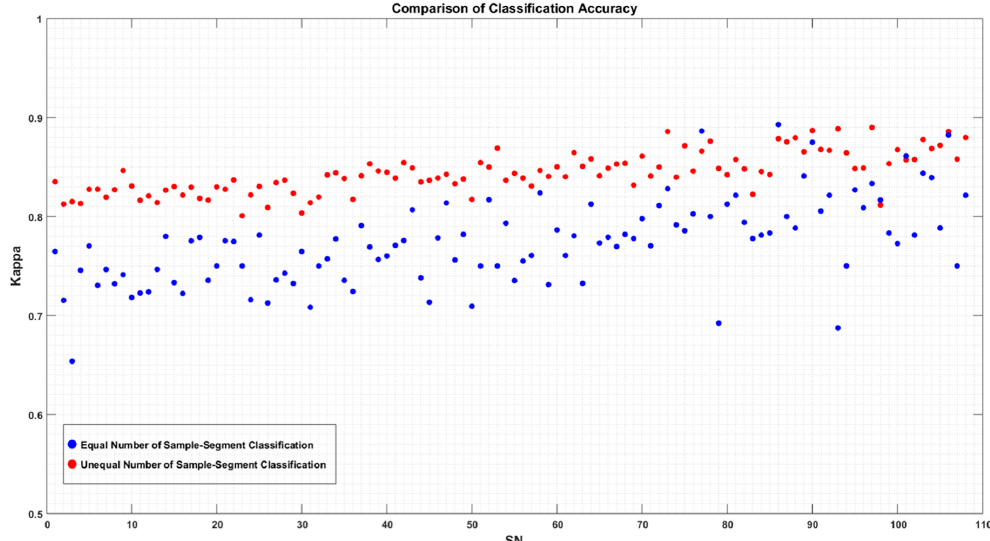
Figure 13. Comparison of classification accuracies of equal and unequal number of sample-segment classifications based on SSM 3. classifications based on SSM